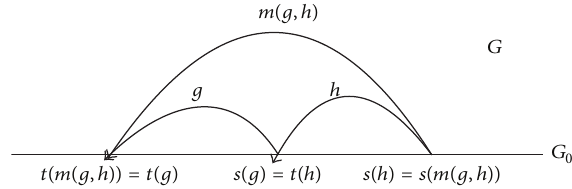
Figure 1: Two arrows 𝑔 and ℎ ∈ 𝐺 , with the target of ℎ , 𝑡(ℎ) ∈ 𝐺 0 , equal to the source of 𝑔 , 𝑠(𝑔) ∈ 𝐺 0 , and the composed arrow 𝑚(𝑔,ℎ)